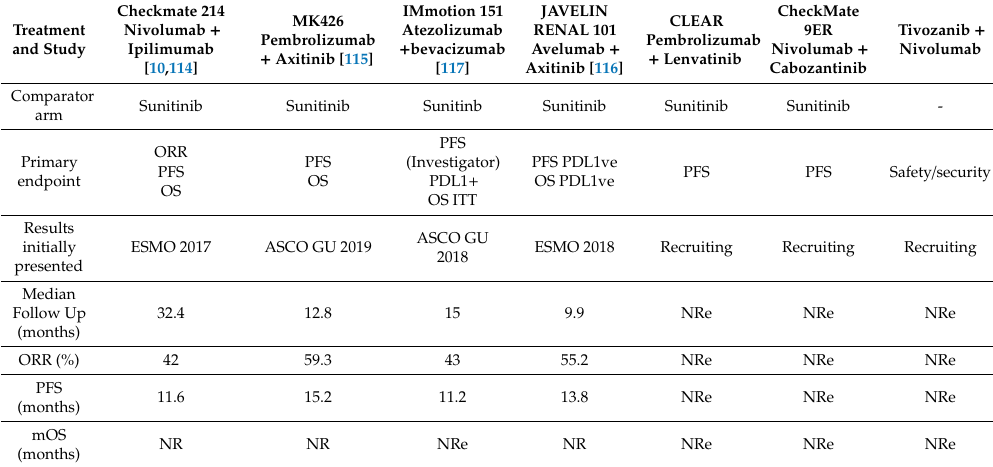
Table 3. Recently approved combinations and upcoming drugs in the first line treatment for patients with metastatic renal cell carcinoma (RCC) combining VEGF / R and PD1 / PDL1 inhibition. NR: Not reached; NRe: Not